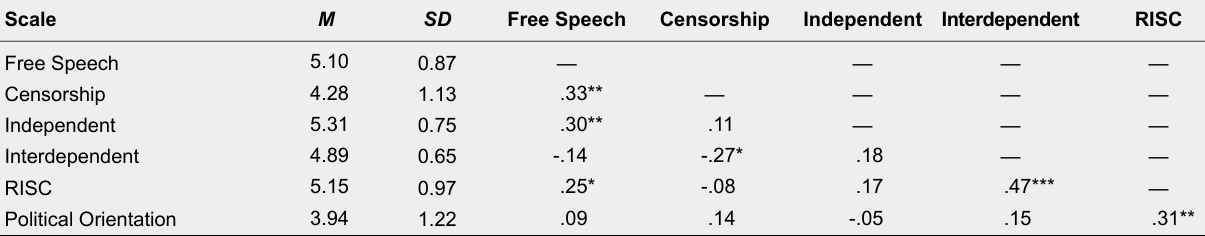
Means, Standard Deviations, and Correlations for all Scales (Study 2)